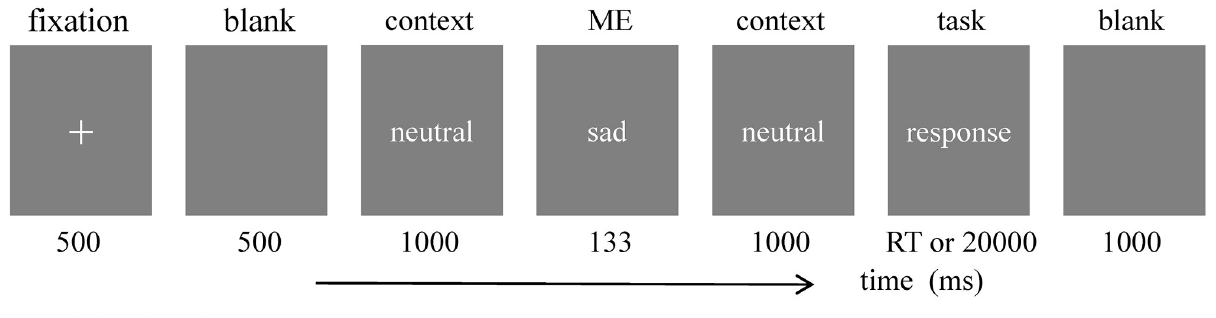
Fig 1. The flow chart of one